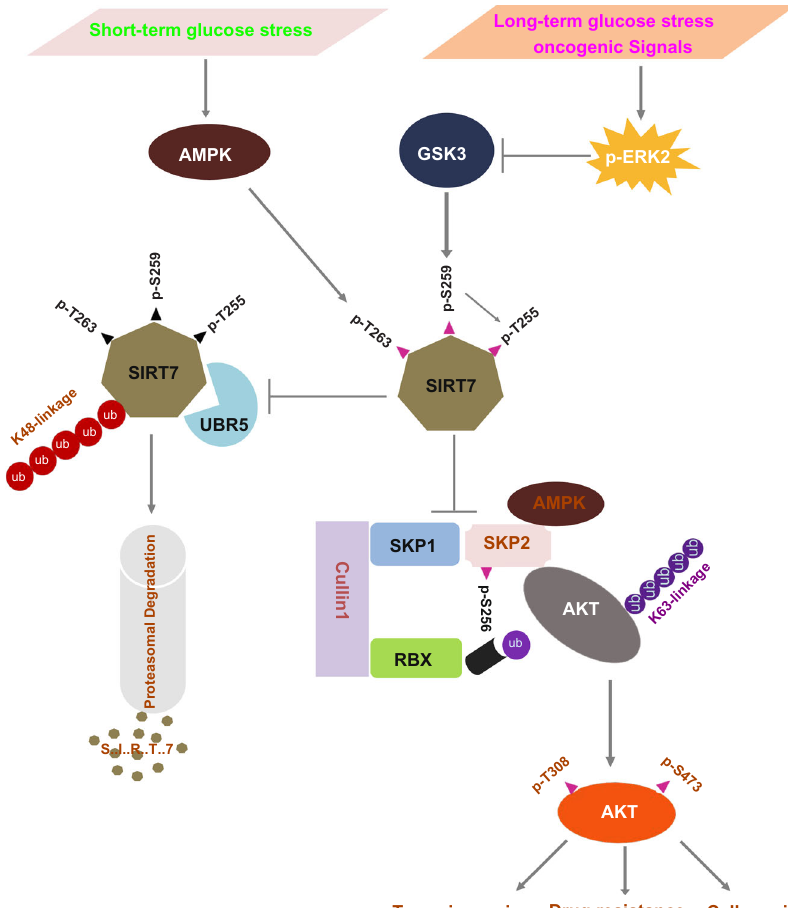
Fig. 8 Oncogenic and energetic stress signals converge at the GSK3 β – SIRT7 axis. Short term and mild energetic stress activating AMPK to prime the phosphorylation of Thr263 leads SIRT7 to be further phosphorylated at Thr255/Ser259 by GSK3 β , which prevents UBR5-mediated SIRT7 K48- polyubiquitination and subsequent proteasomal degradation. As a result, phosphorylated SIRT7 inhibits the integrity of the SCF-SKP2 E3 ligase complex which facilitates AKT K63 polyubiquitination and thus activation. In contrast, long term or extreme energetic stress and/or oncogenic signals hijack the GSK3 β – SIRT7 axis by activating ERK2, leading to SIRT7 loss of phosphorylation, and AKT overactivation, which contributes to tumorigenesis, drug resistance, and cell survival. Thus, SIRT7 serves as a central hub that senses oncogenic signals and energetic stress and manipulates malignant